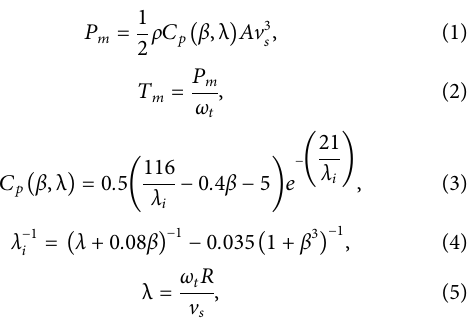
where P m depicts the wind power captured, T m is the wind turbine output torque, A depicts the blades ’ area, ρ is fl uid density, λ is speed ratio, v s denotes the wind speed, β depicts pitch angle, ω t depicts turbine speed, R is the blades ’ radius, and C p is power coef fi cient.